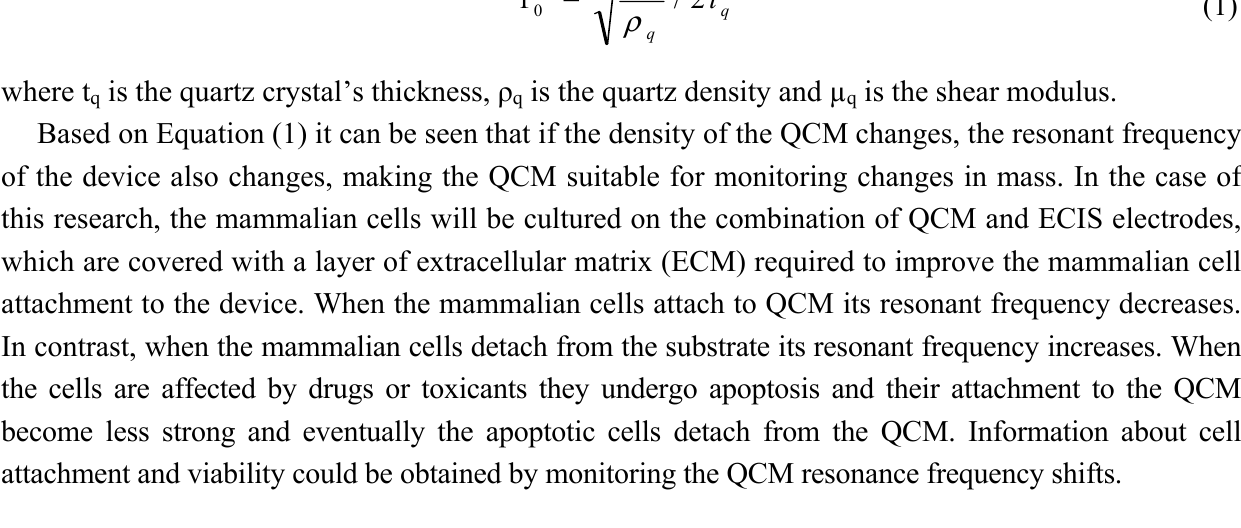
Figure 2. Illustration of the working principle of the hybrid biosensor which integrates acoustic wave sensing with impedance spectroscopy